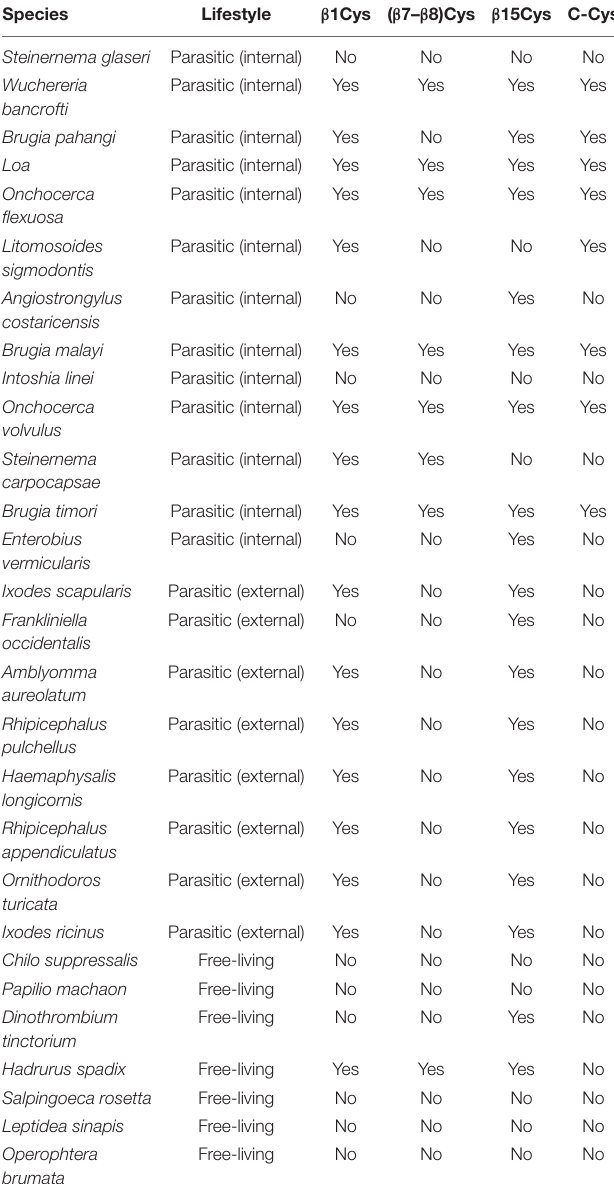
TABLE 1 | List of organisms with redox-sensitive VDAC being the only VDAC variant, classified by their lifestyle and the presence or absence of cysteine residues in selected regions of the